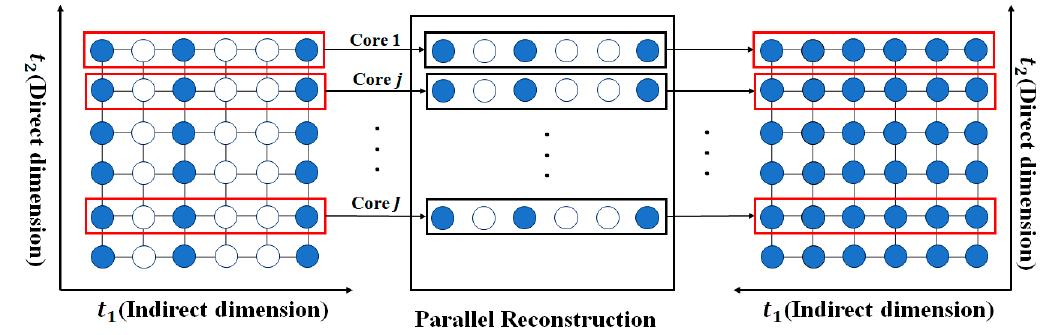
Figure 1. Schematic diagram of parallel computing of NMR spectroscopy reconstruction. Note: The blue dot represents the sampled data point and the white one represents unsampled data point; “Core j” represents the j th CPU (Central Processing Unit) core of a multi-core CPU for parallel computation. The non-uniform sampling (NUS) is performed along the indirect dimension ( t 1 ), and each 1D vector (in red rectangle) located at each data point in the direct dimension ( t 2 ) can be reconstructed separately.